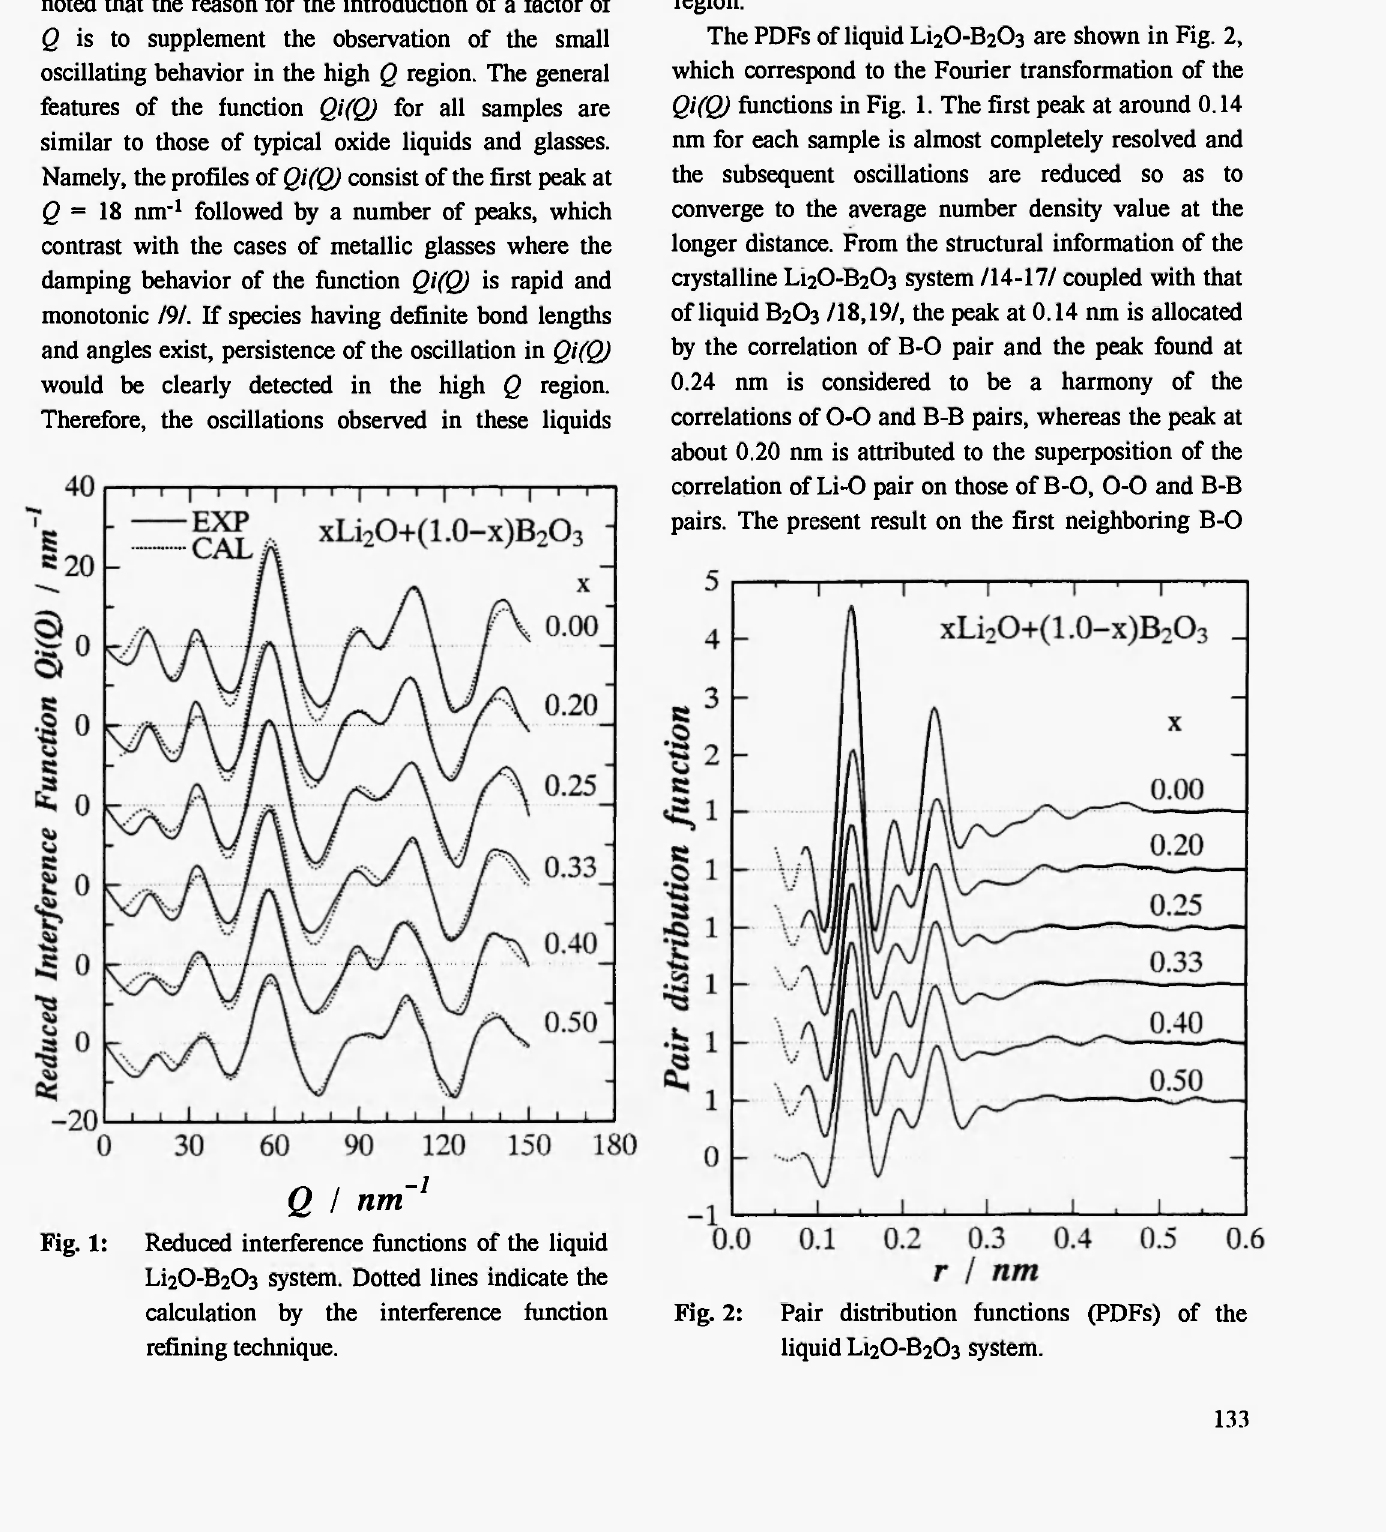
Fig. 1: Reduced interference functions of the liquid Π2Ο-Β2Ο3 system. Dotted lines indicate the calculation by the interference function refining technique.